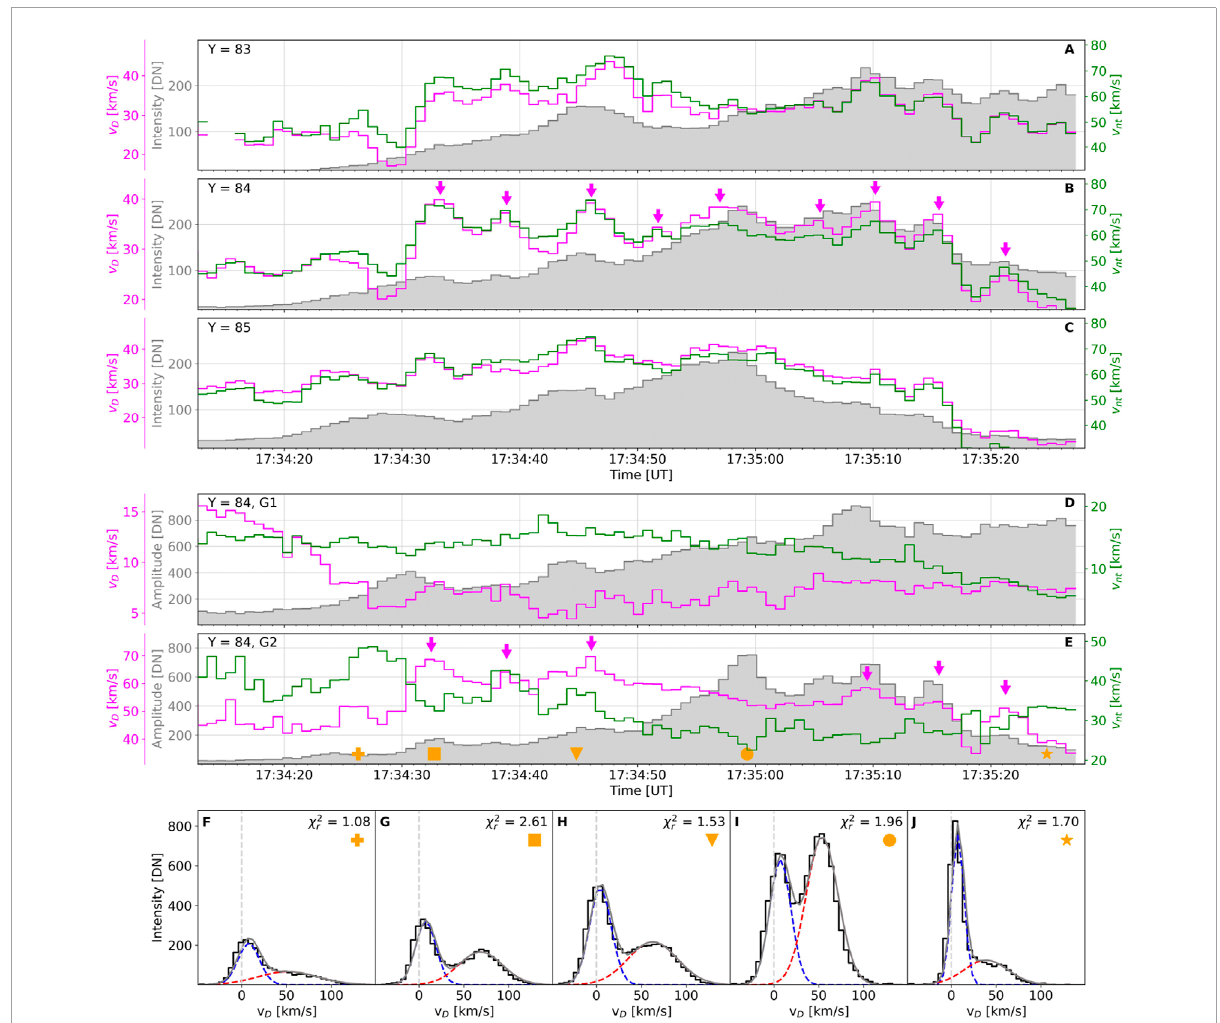
FIGURE 4 Panels (A–E) detail the time evolution of the total intensity (resp. intensity amplitude, grey), the Doppler velocity (magenta), and the non-thermal broadening (green) of the Si IV 1402.77Å line. The curves plotted in panels (A–C) were obtained at 3 different pixel positions along the slit, 83 through 85, via the moment analysis. The time evolution of these quantities at the pixel position 84 (black arrow in Figures 3A–C ) obtained via two-Gaussian fitting is detailed in panels (D) and (E). The first Gaussian (G1) is shown in panel (D) , while the second Gaussian is shown in panel (E) . Magenta arrows in panels (B) and (E) highlight selected enhancements in the Doppler velocity determined from the moment analysis and Gaussian fitting, respectively. The orange symbols plotted in panel (E) mark the instants of observations of profiles displayed in panels (F–J) . There, the observed profiles are plotted in black, the Gaussian fits to the near-at-rest and secondary redshifted components are plotted in blue and red, respectively, and the total fit to the profiles are in grey. In top-right corner of each panel, reduced chi-squared statistic of the respective fit is